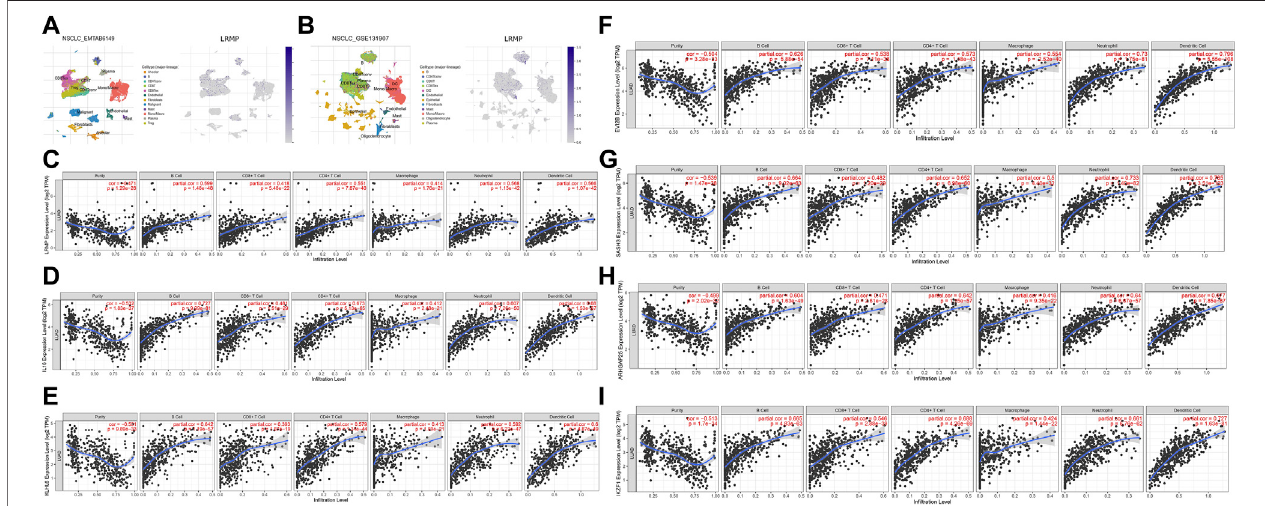
FIGURE 7 | Correlation of lymphoid-restricted membrane protein ( LRMP ) and its co-expressed genes with tumor-in fi ltrating immune cell in lung adenocarcinoma (LUAD). (A – B) Single-cell distribution of LRMP in the LUAD microenvironment in EMTAB6149 and GSE 131907 datasets. (C – I) Correlation of LRMP, IL16, KLHL6, EVI2B, SASH3, ARHGAP25 , and IKZF1 expression with tumor-in fi ltrating- immune in LUAD.